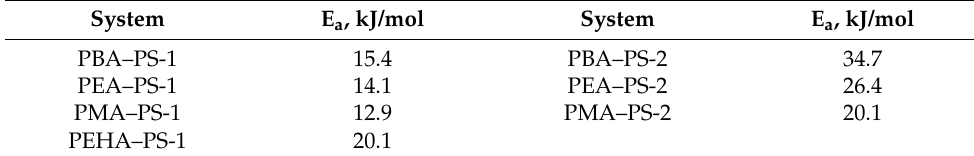
Table 2. Activation energy of diffusion of PS-1 and PS-2 macromolecules into polyacrylates. System